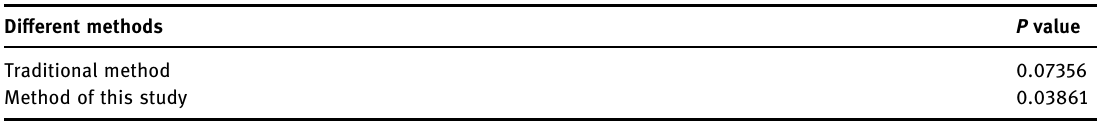
Table 4: Statistical evaluation results of di ff erent